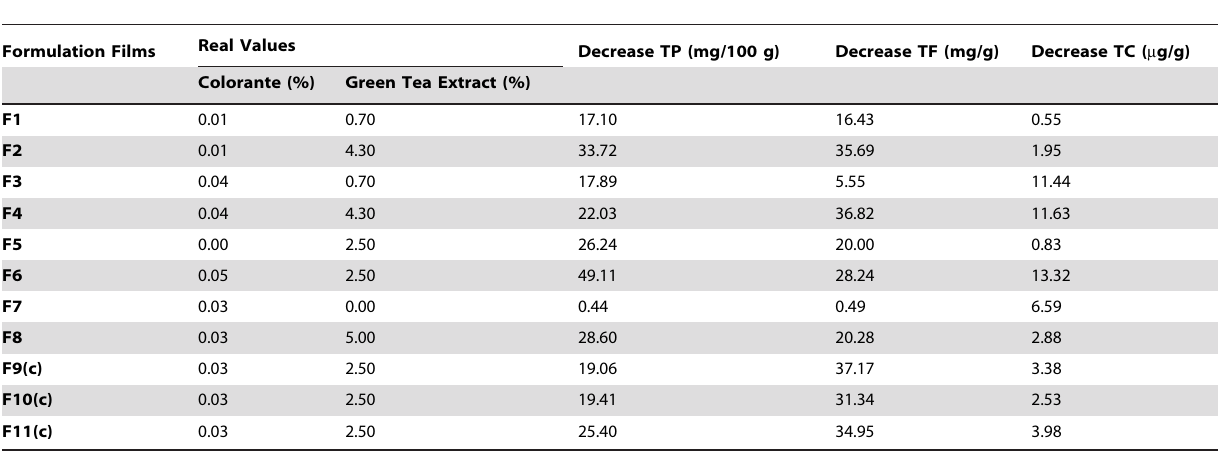
Table 3. Decrease of antioxidants in the film formulations with different concentrations of green tea extracts and carotenoic colorant after butter storage by 45 days.